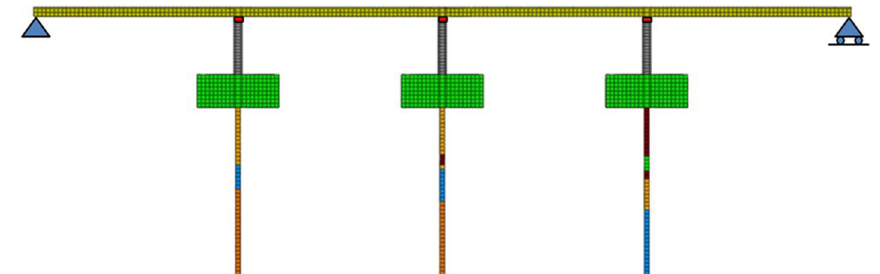
Fig. 1 1DT-3C wave propagation model for soil-bridge interaction analysis: beam bridge assembled with a T-shaped soil domain for each